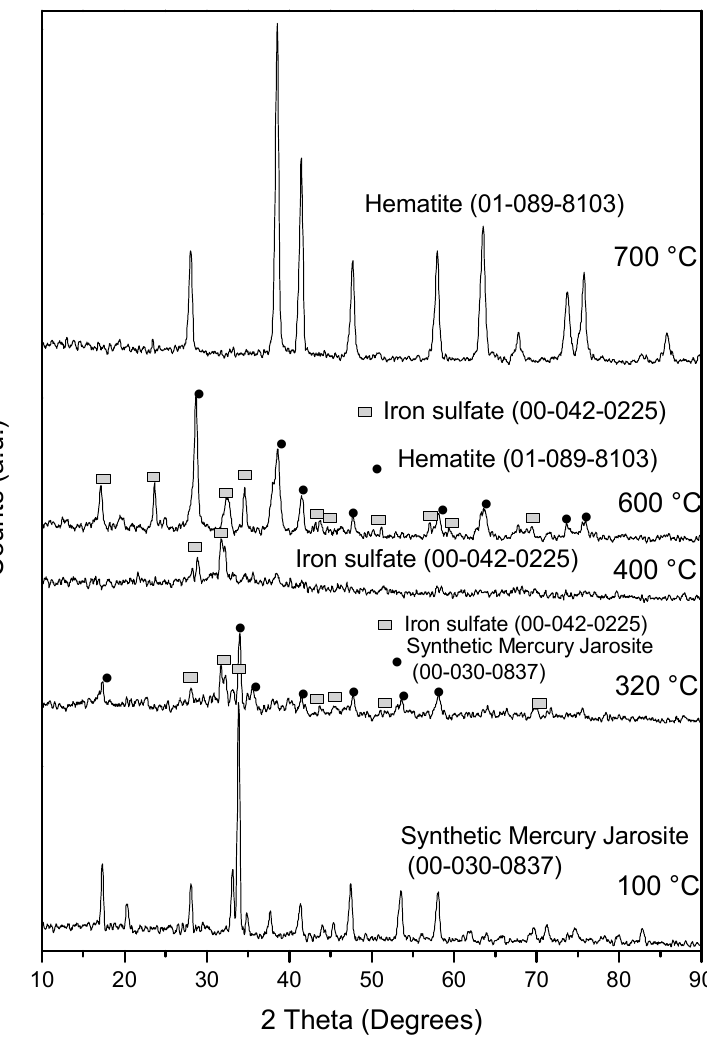
Figure 5. X-ray diffraction patterns of synthetic mercury jarosite and residues after calcination at different temperatures.